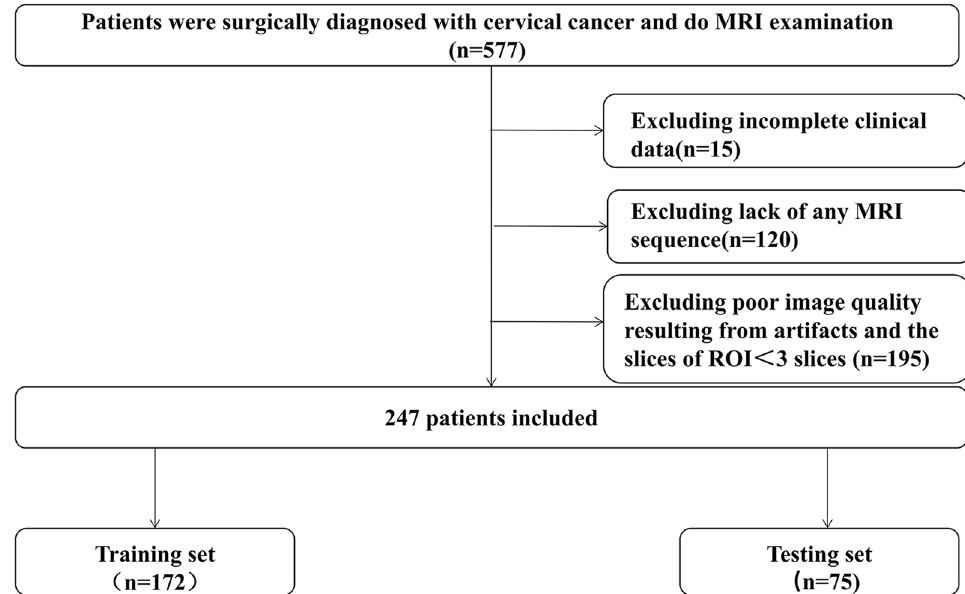
Fig. 1 The flowchart for patients recruitment in this